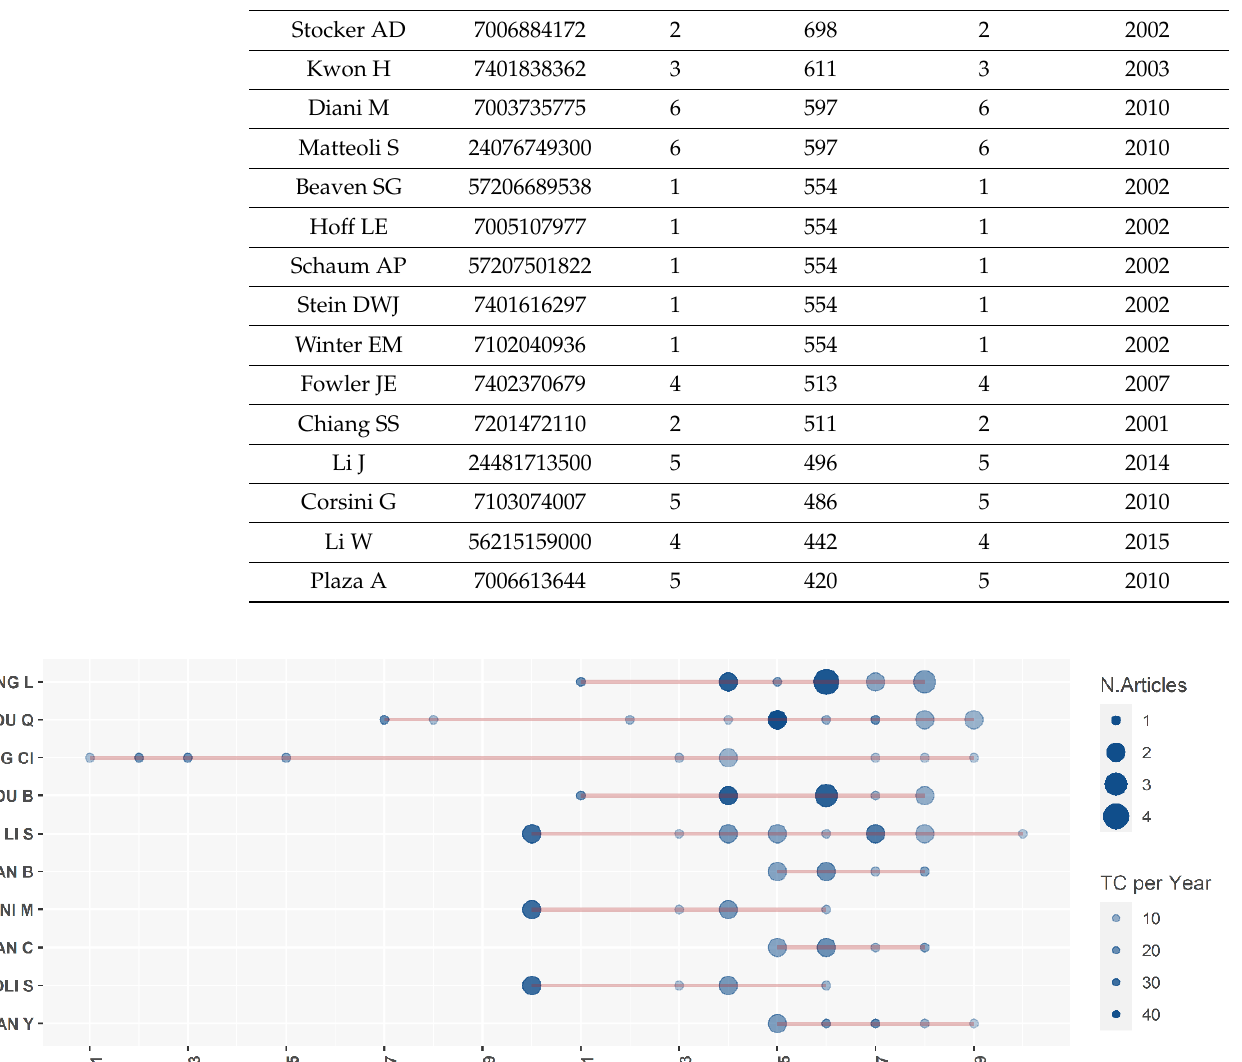
Table 3. The statistics of the 20 most relevant authors in the topic, sorted by total number of cita- tions.